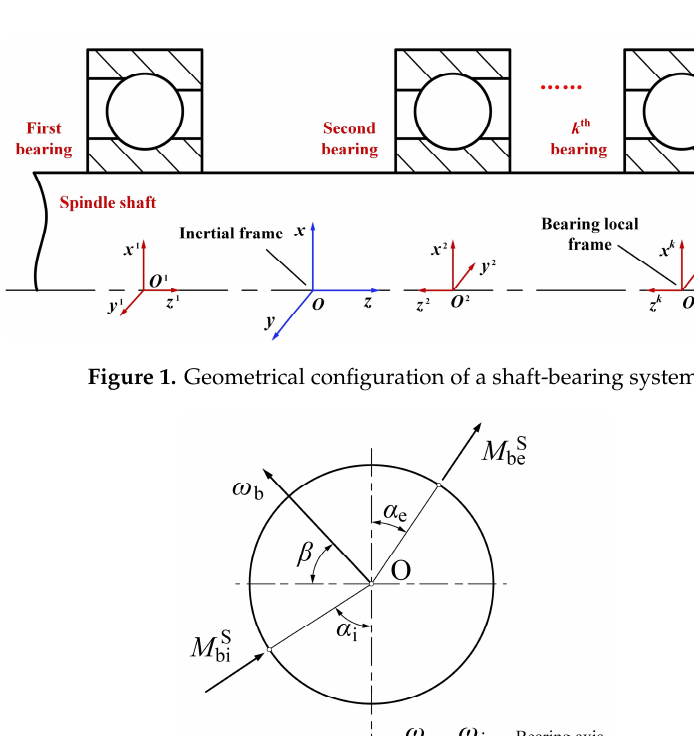
Figure 2. Kinematic relation of a ball element.